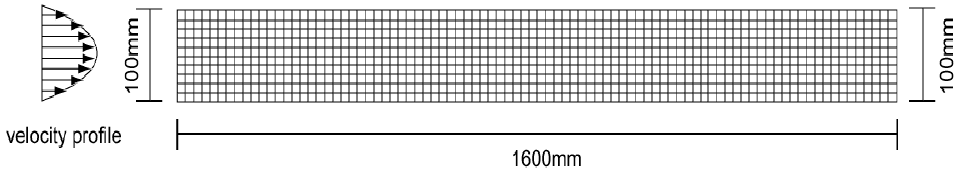
Figure 2. Considered shear flow, number of stream lines, and flow distance lines.